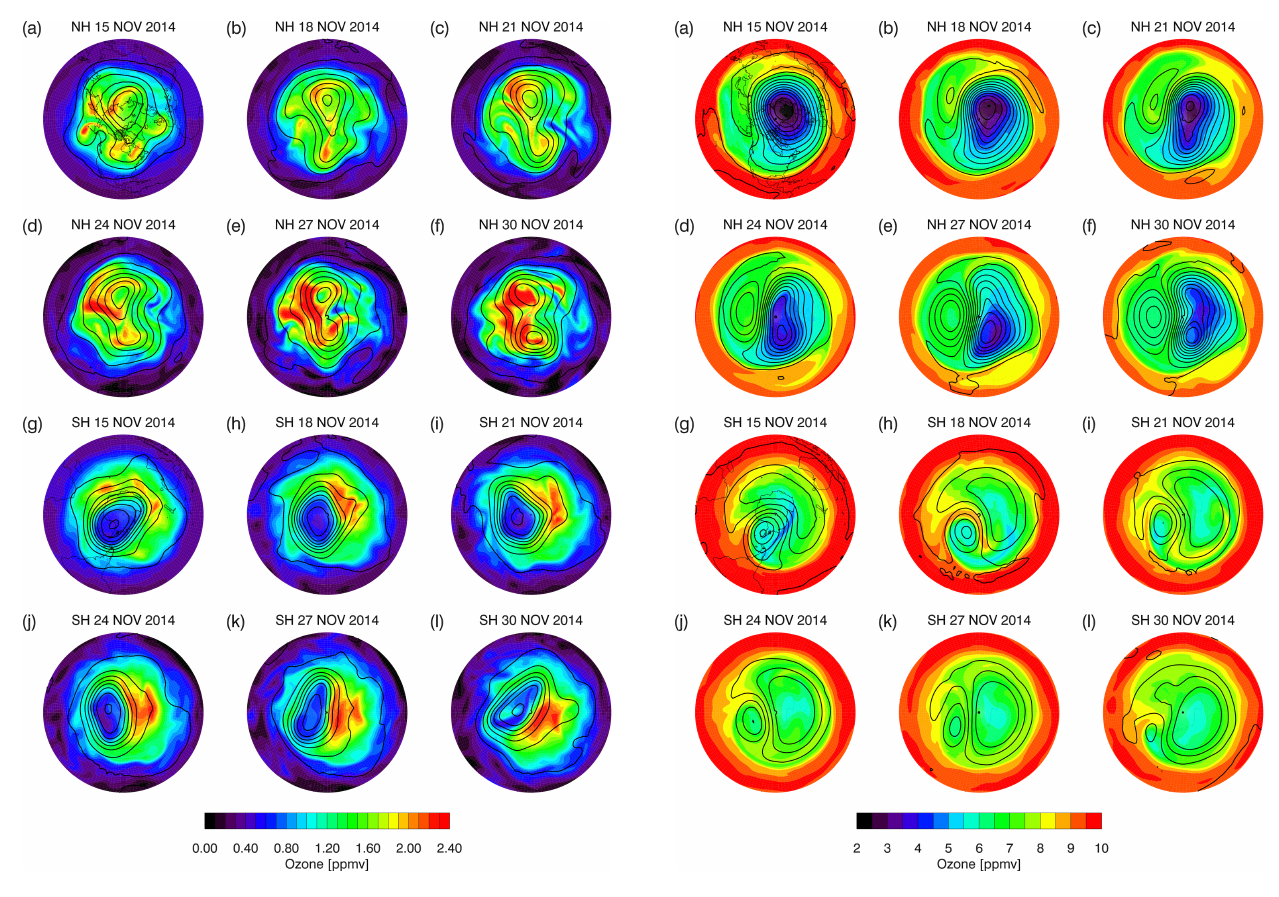
Figure 5. Maps of ozone (ppmv) (colors) at 77hPa ( ∼ 18km) over- laid with geopotential height (black lines) at 200m intervals for 15, 18, 21, 24, 27, and 30 November 2014 (all at 00:00Z). Panels (a– f) are NH and (g–l) are SH. Red (blue) contours indicated high (low) ozone values. Continent lines are placed on the maps for 15 Novem- ber.